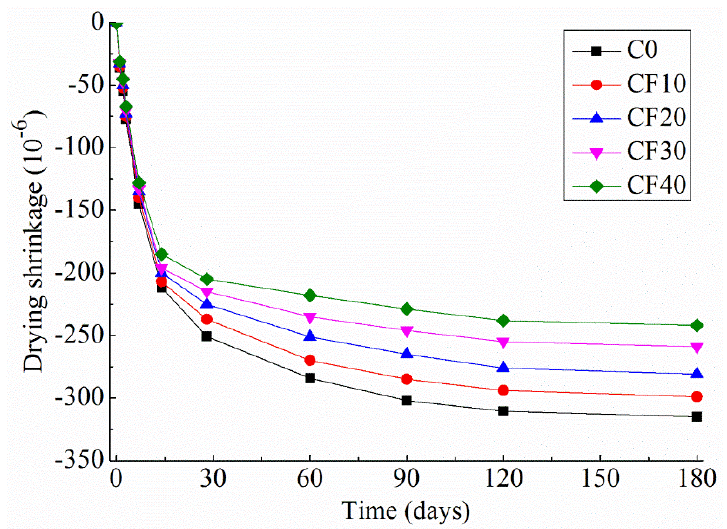
Figure 4. Drying shrinkage of face slab concretes with various fly ash dosages.